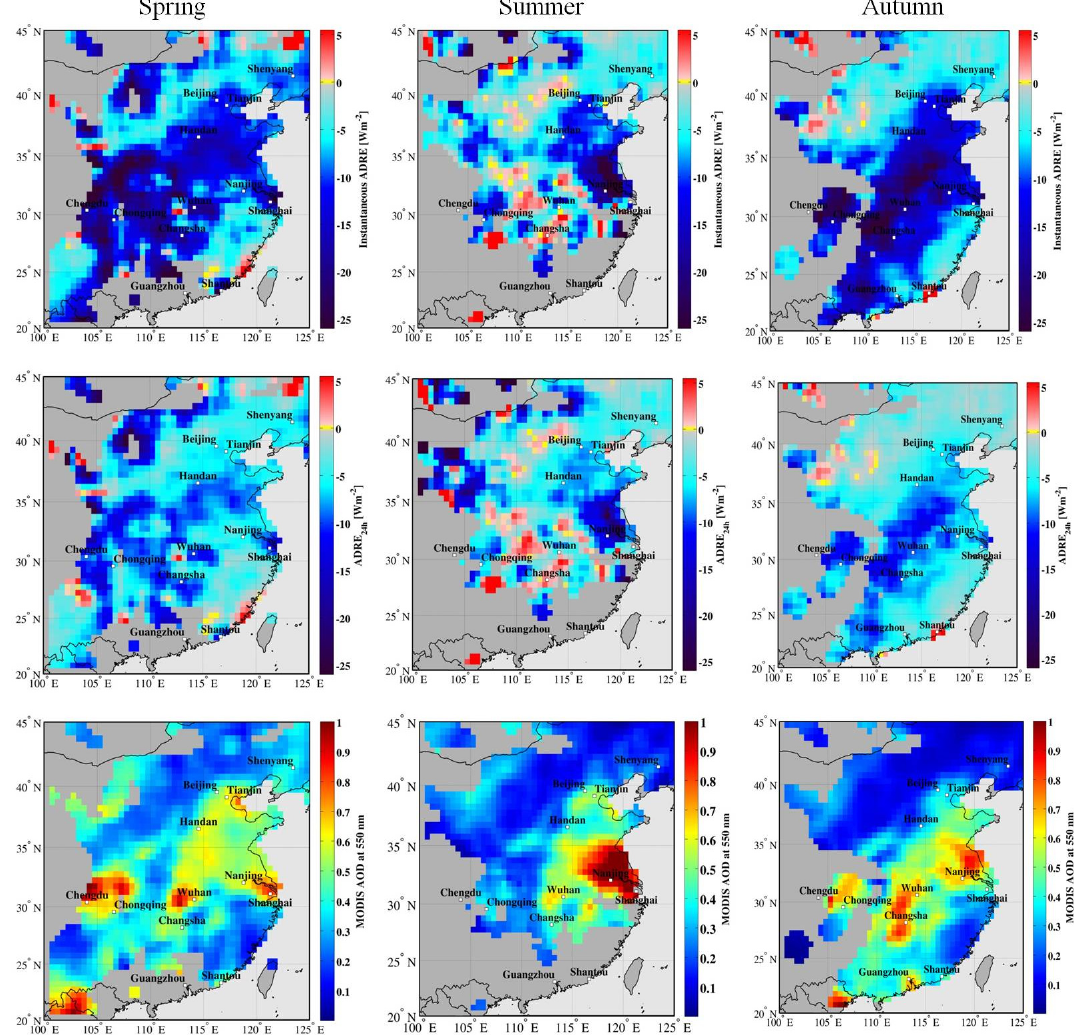
Figure 12. Seasonal geographical distributions of instantaneous (upper row) and 24h averaged (middle row) median values as well as the corresponding median AODs (lower row) which have been used in the linear fitting against CERES fluxes. The 24h averaged ADRE accounts only for the SZA diurnal variation, whereas other parameters such as AOD and water vapor content were assumed to be constant in the diurnal